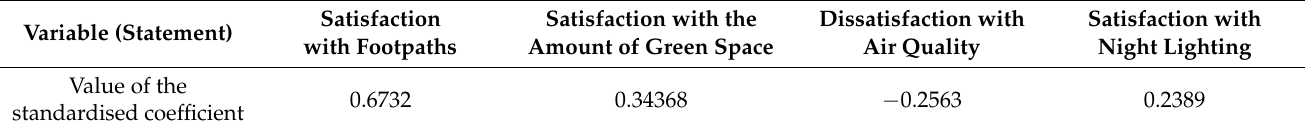
Table 9. Standardised coefficients of the canonical discrimination function for discriminating